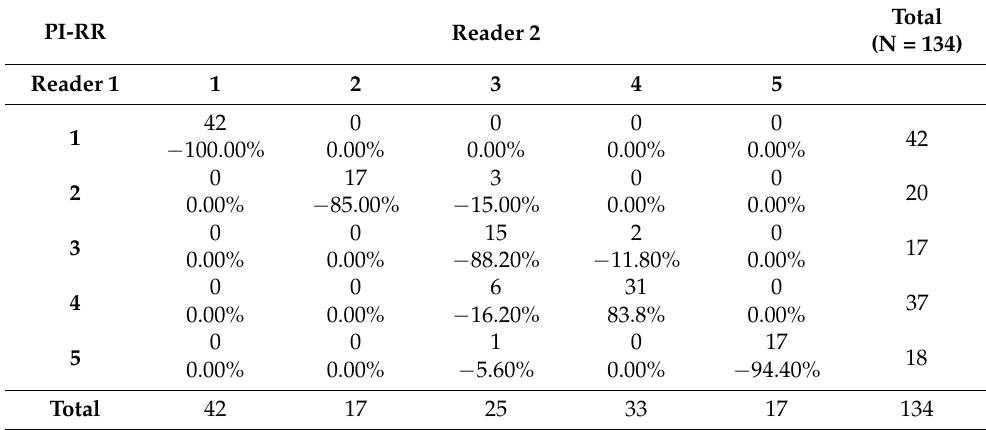
Table 3. Scoring agreement between reader 1 and reader 2.